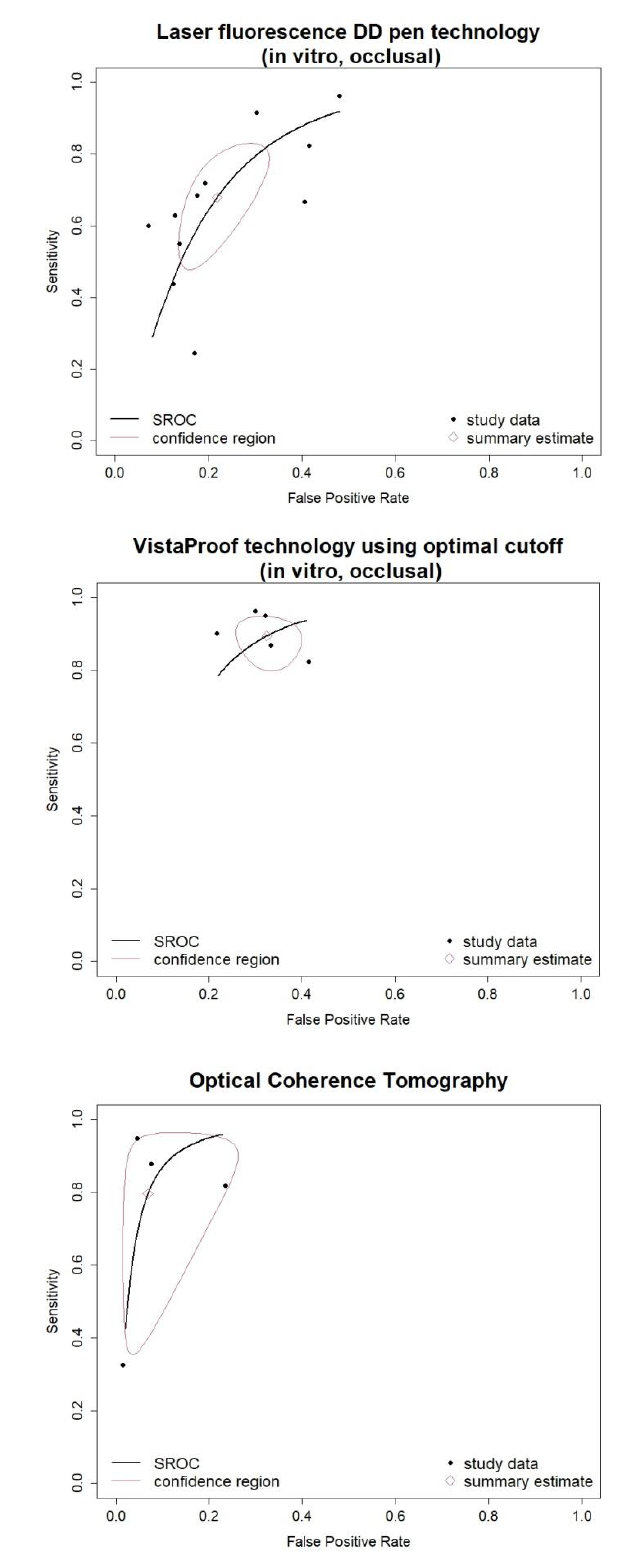
Figure 4. Bivariate summary ROC (sROC) curves for the three groups of index tests included in the comprehensive bivariate meta-analysis: LF DD pen occlusal, in vitro; FC VistaProof using optimal cut-off, in vitro; OCT overall. They also integrate the individual studies’ data in a summary bi-dimensional estimate and show its 95% prediction